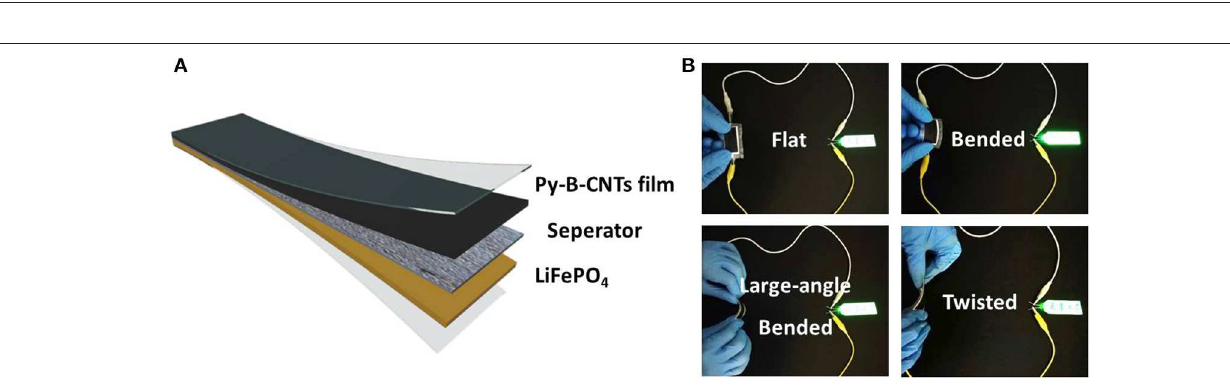
FIGURE 4 | (A) CV loops of the py-B-CNTs film obtained at 0.1mV s − 1 ; (B) galvanostatic charge-discharge (GCD) profiles of py-B-CNTs film; (C) cycling performances of the py-B-CNTs and pristine CNTs films for 300 cycles at 100mA g − 1 ; (D) rate capability of the materials at various rates of 0.05-2A g − 1 ; (E) electrochemical impedance spectra of py-B-CNTs and pristine CNTs films and the equivalent circuit to fit the EIS; (F) the fitted curve of impedance (Z ′ ) vs. the reciprocal square root of the angular frequency ( ω ) for py-B-CNTs film.